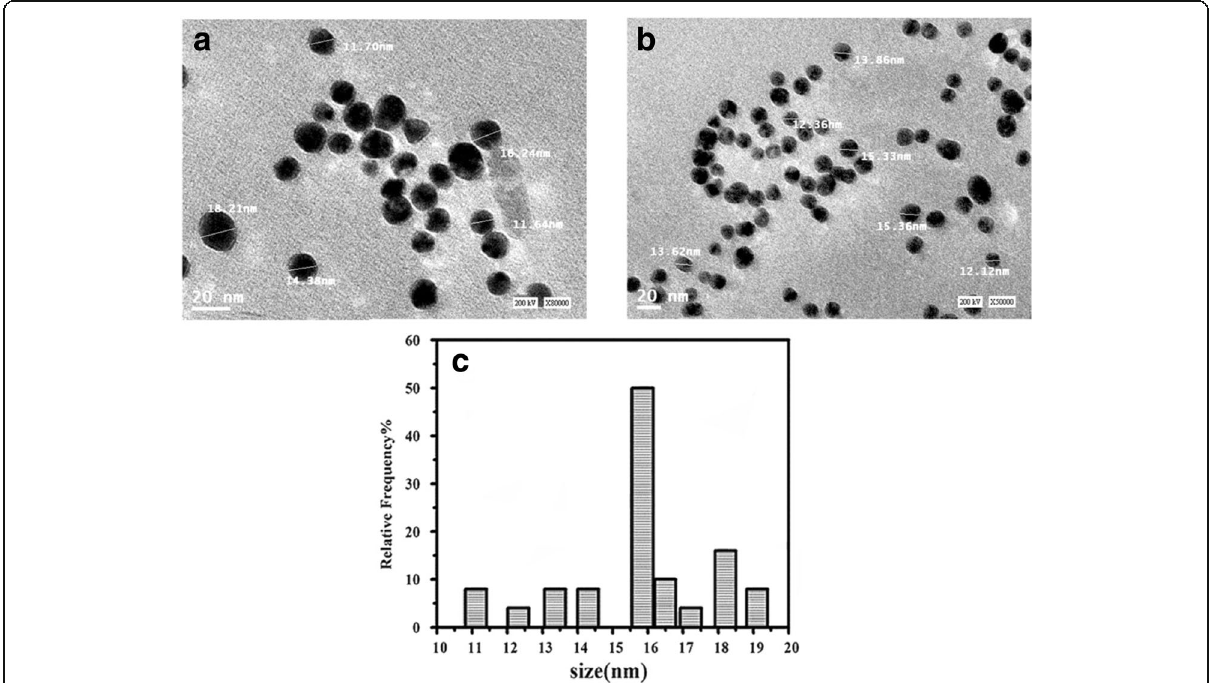
Fig. 1 a – c TEM micrograph of GNPs and the size distribution histogram of